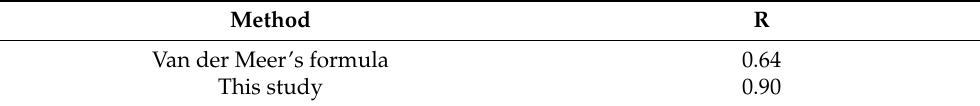
Table 3. Comparison of the evaluation index between our model and Van der Meer’s formula.